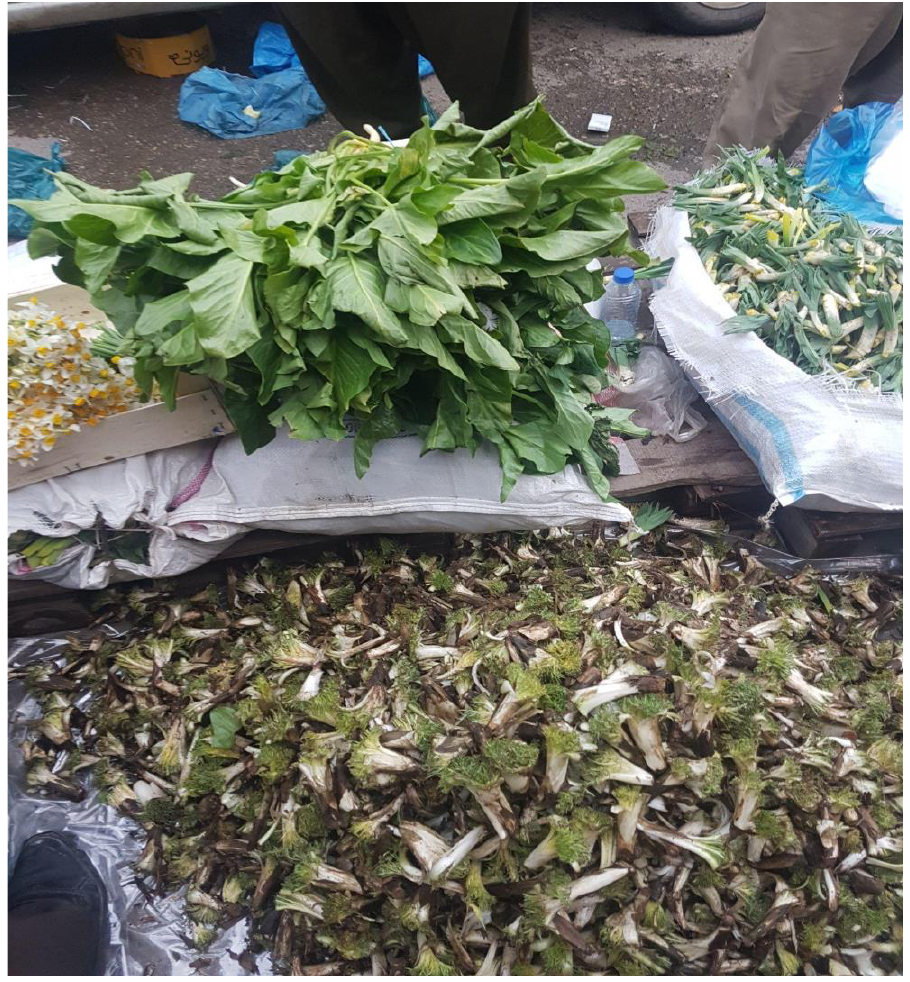
Figure 2. Wild food plants ( Arum spp. in the middle upper part of the picture and Gundelia tournefortii in the bottom) sold in a local market in Kurdistan (Photo: Ahmed H.M.).